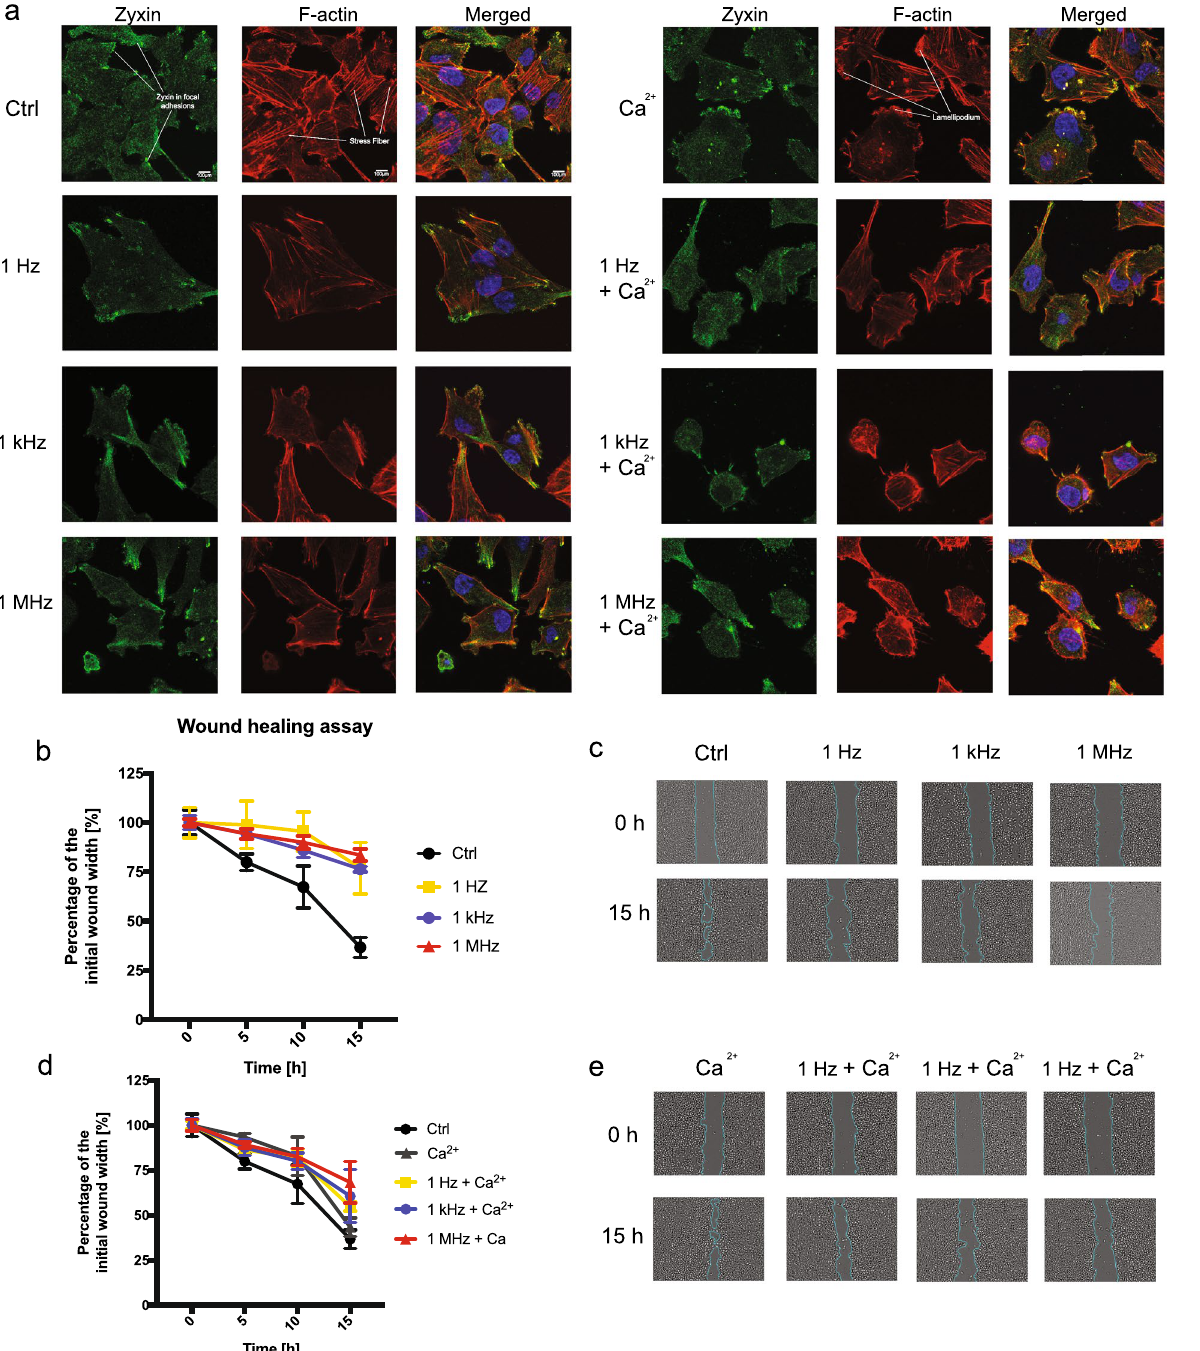
Figure 5. PCa cells morphology and mobility after exposure to 25, 10 kV/cm, 200 ns pulses in different frequencies with and without extracellular Ca 2+ . ( a ) The representative photographs of cells exposed to bursts of nsPEFs. Confocal laser scanning microscopy visualize the rearrangement of zyxin (green fluorescent dye), F-actin (red fluorescent dye) nucleus (blue florescent dye) structure in DU 145 cells. ( b , c ) The percentage of a healed wound as a function of time. Images were analyzed by ImageJ software (Version: 2.1.0/1.53C; https:// imagej. net/ Fiji) 28 . ( d , e ) Images of wound gradually invaded by migrating cells. Images were taken in a given time interval. The graph represents the data from the three replicates of an individual experiment. Data are mean ± SD (n = 3